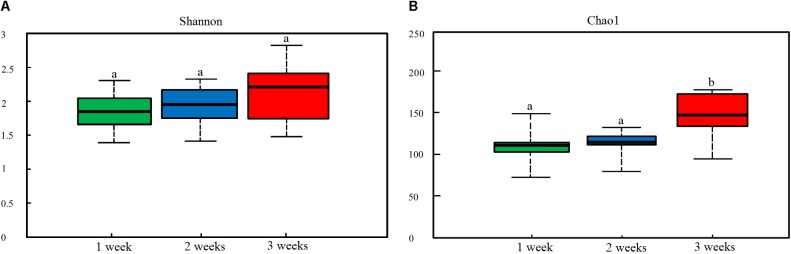
Dynamic changes in gut microbial alpha diversity of PEDV-infected piglets determined by (A) Shannon index and (B) Chao1 index. Different letters above the bars denote a significant difference in alpha diversity index among the groups tested by paired sample Wilcoxon signed-rank test and adjusted for false discovery rate (FDR, p < 0.05).